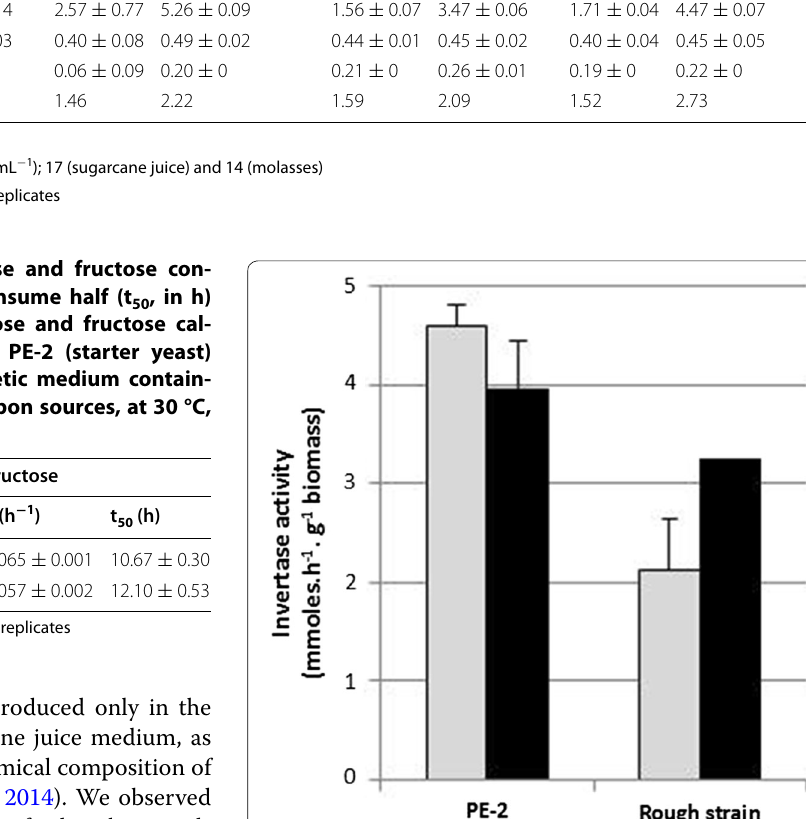
Table 2 Composition of the fermented broth at the end of the 6th fermentative cycle in fermentations carried out with the industrial S. cerevisiae yeast (PE-2) contaminated with the rough strain of S. cerevisiae (rough) and/or L. fermentum (Lf) in sugarcane juice or molasses at 30 °C Composition (g 100 mL − 1 )